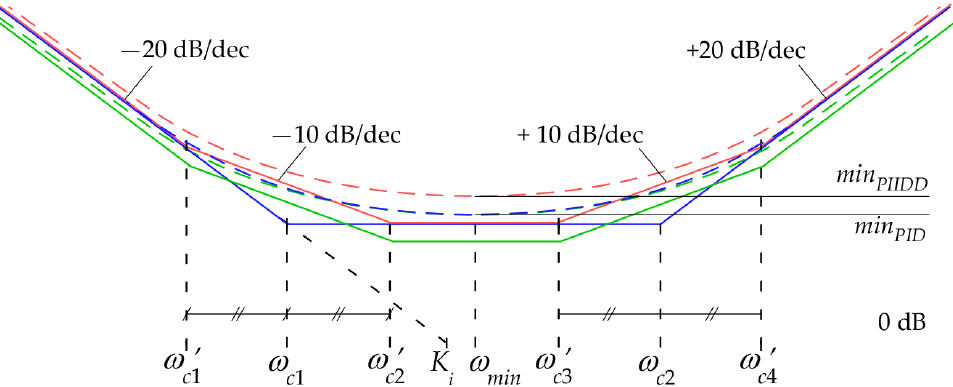
Figure 4. Derivation of the PII 1/2 DD 1/2 control parameters from the PID control Bode plot: PID (blue); PII 1/2 DD 1/2 with tuning C H (red); PII 1/2 DD 1/2 with tuning C L (green).